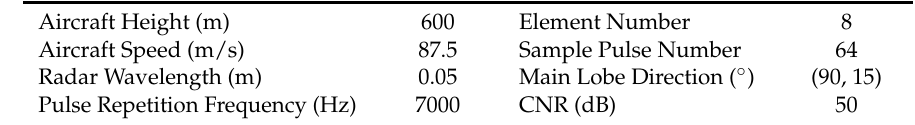
Table 2. Parameter values of aircraft and radar.